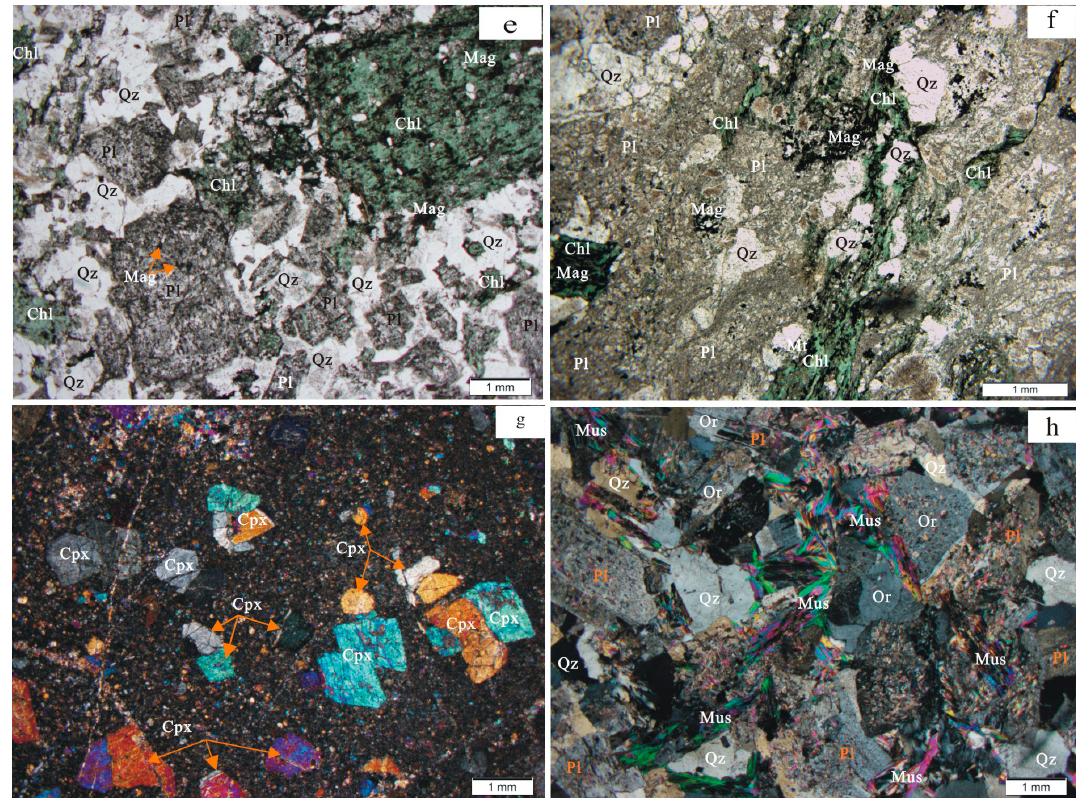
Figure 3. ( a ) The DBS open pit showing intrusive contacts between the Ordovician granodiorite and the Mesozoic quartz-monzonite. Note that white solid circles with orange arrows are sampling sites. ( b ) Photograph of a mineralized granodiorite with narrow chalcopyrite-quartz veinlets and disseminated chalcopyrite and propylitic alteration. ( c ) Photograph of a typical granodiorite with strong propylitic alteration and earlier weak potassic alteration. ( d ) Photograph of a typical microgabbro with moderate propylitic alteration. ( e ) Photomicrograph of an altered porphyritic granodiorite (sample DBS1) with altered plagioclase (Pl) and hornblende pseudomorphically replaced by chlorite (Chl) and magnetite (Mag). ( f ) Photomicrograph of a mineralized granodiorite (sample DBS16). Note that the aggregates of green chlorite, epidote (Ep) and magnetite (Mag) replace primary hornblende. ( g ) Photomicrograph of a microgabbro (sample DBS7) containing phenocrysts of clinopyroxene (Cpx) in the groundmass of fine-grained plagioclase and clinopyroxene. ( h ) Photomicrograph of a quartz-monzonite (sample DBSA1) containing coarse-grained orthoclase (Or), plagioclase (Pl), biotite (Bi), and muscovite